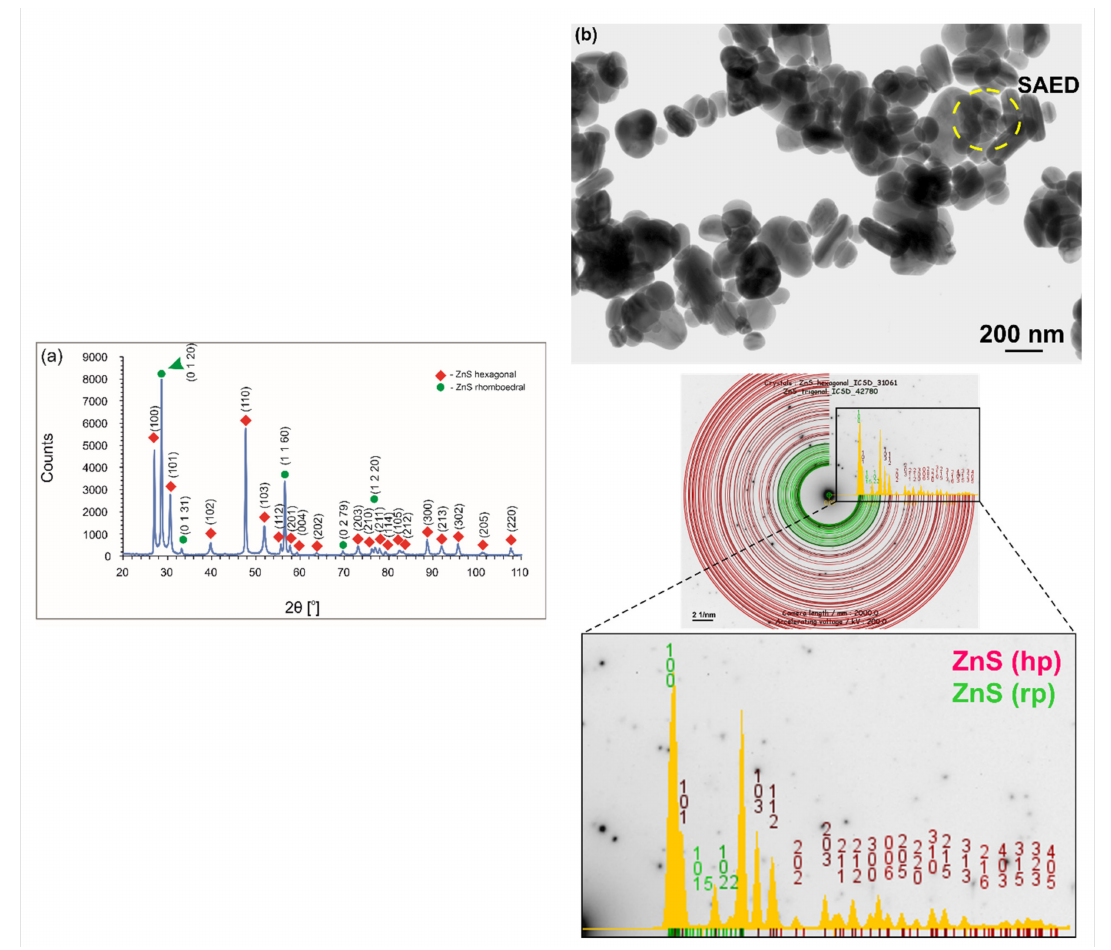
Figure 3. XRD pattern ( a ) and TEM micrograph ( b ) of ZnS particles. ( b ) also shows the SAED pattern obtained from the area marked by a circle and its interpretation with JEMS software.